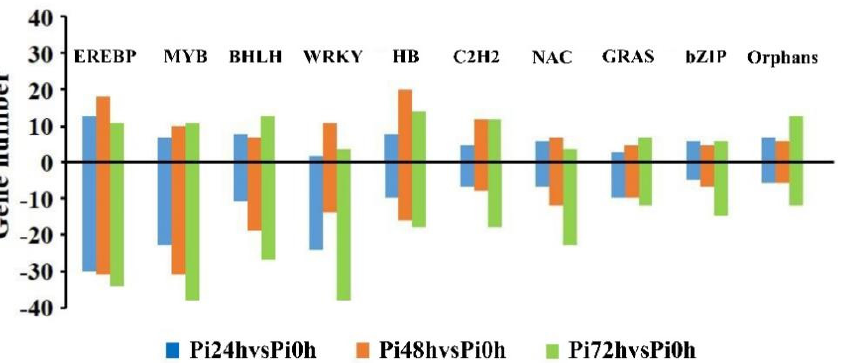
Figure 6. Histogram of the number of genes in the top 10 differentially expressed transcription factor families with the most members. Blue, red and green represent group Pi24h vs. Pi0h, group Pi48h vs. Pi0h and group Pi72h vs. Pi0h, respectively. The upper part of the x-axis represents the number of upregulated expressed genes, and the lower part is the number of downregulated expressed genes.